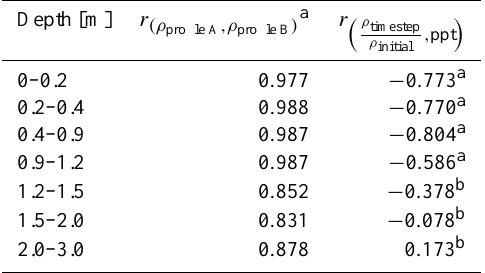
Table 4. Correlation between median resistivity of profiles A ( ρ profile A ) and B ( ρ profile B ) and between subsequent resistiv- ity ratio of profile A ( ρ timestep /ρ initial ) and cumulative precipitation during the time step